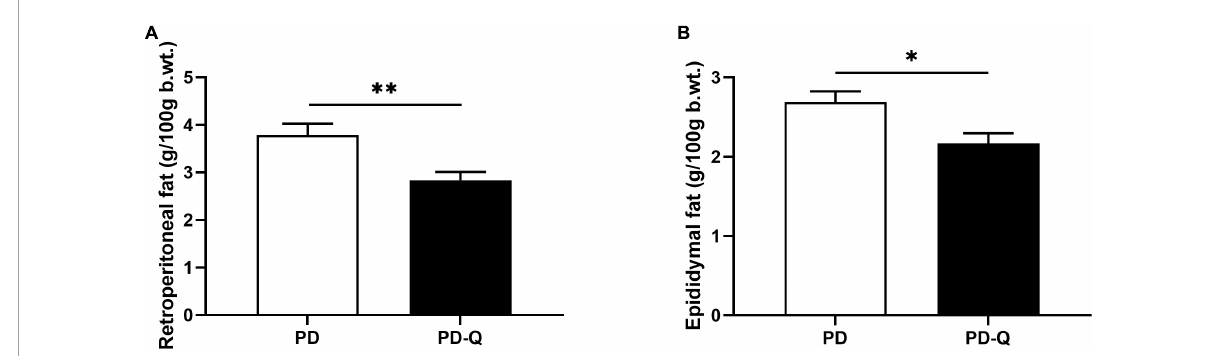
FIGURE1 Effect of quercetin supplementation on retroperitoneal (A) and epididymal fat (B) . Values are mean ± SEM, n = 6/group, * p < 0.05, ** p < 0.01. PD, control rats; PD-Q, rats supplemented with quercetin; b.wt., body